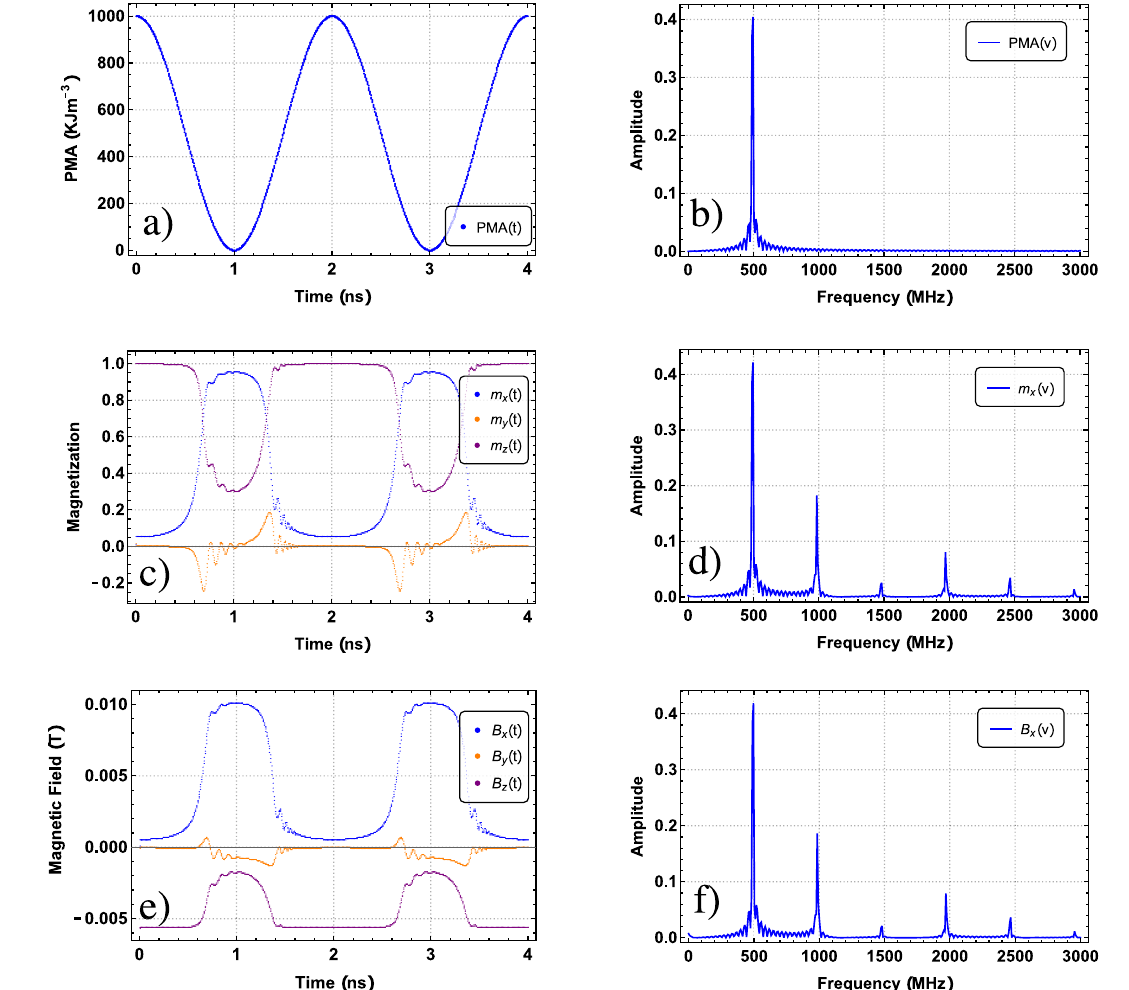
Fig. 3 Nanomagnet driven at 500 MHz. a Sinusoidal perpendicular magnetic anisotropy in the time domain and b in the frequency domain. Panels c and d show magnetization ( m x , m y , m z ) of a nanomagnet in time and frequency domain, respectively . Panels e and f indicate induced magnetic fi eld ( B x , B y , B z ) in the qubit volume in time, and frequency domain, respectively.